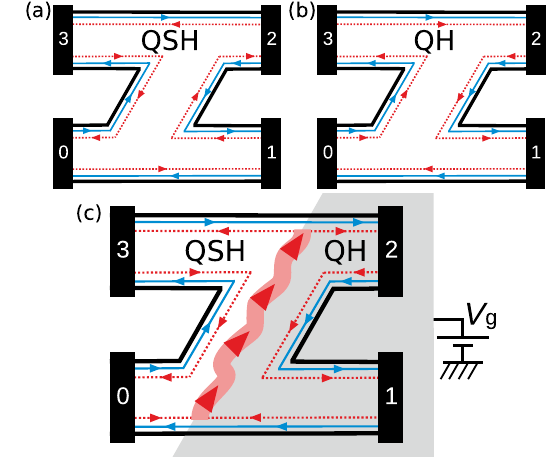
FIG. 1. Schematics for the edge states in a four-terminal Z-shape geometry when the system is in the (a) QSH phase and the (b) QH phase. In (a), opposite spins (thick blue lines and red dotted lines) propagate in opposite directions on a given edge, while in (b), they propagate in the same direction. (c) Topological heterojunction, with QSH edge states on the left and QH edge states on the right. This junction can be achieved experimentally by applying a top gate (shaded region) on the right half of the sample. While one of the spin species (thick blue line) can propagate through this junction, the other one (red dotted line) cannot, giving rise to a chiral state, localized at the interface between QH and QSH phases, which connects both